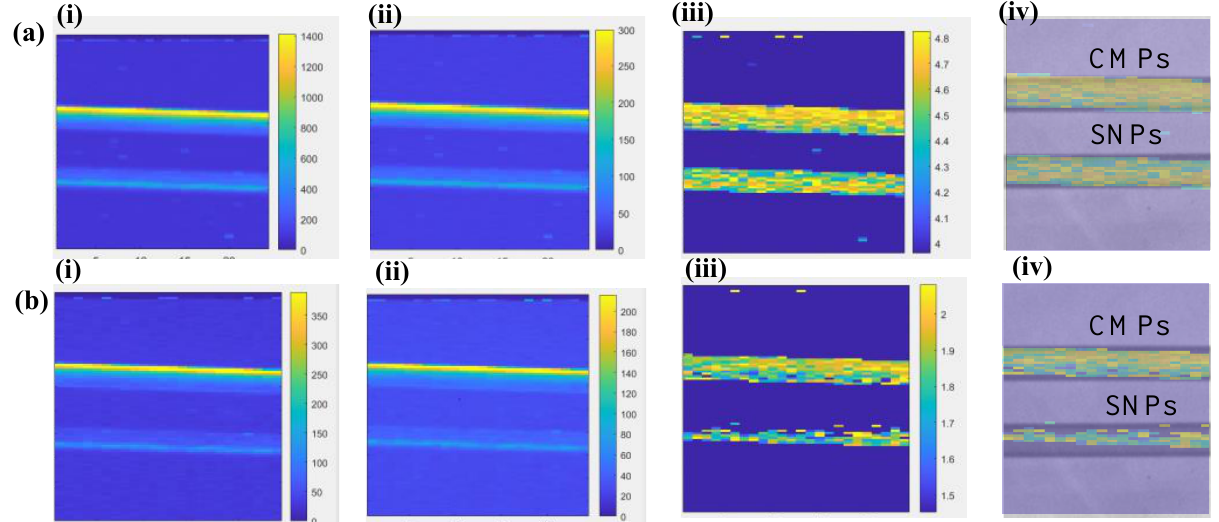
Figure 6. XELCI images of Eu-doped Gd 2 O 2 S pristine commercial microparticles (CMPs) and separated nanoparticles (SNPs) in glass capillaries (1 mm inner diameter). ( a ) XELCI images without tissue ( i ) image of intensity (counts) vs. pixel number at 625 nm ( ii ) image of intensity (counts) vs. pixel number at 700 nm ( iii ) Ratiometric XELCI image (intensity ratio of 625 nm and 705 nm vs. pixel number) ( b ) XELCI images with 5 mm thick porcine tissue ( i) image of intensity (counts) vs. pixel number at 625 nm ( ii ) image of intensity (counts) vs. pixel number at 705 nm ( iii ) Ratiometric XELCI image (intensity ratio of 600 nm and 700 nm vs. pixel number). ( iv ) corresponding images both in ( a ) and ( b ) Superimposed I6 image and X-ray images.